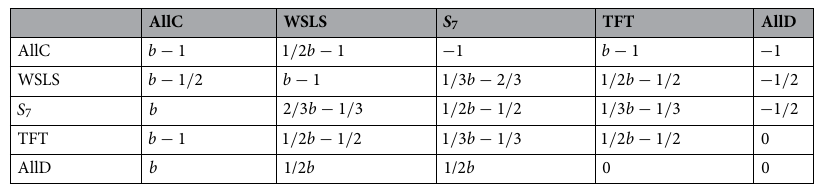
Table 2. Payoff matrix for the reduced strategy space, consisting of AllC, WSLS, S 7 , TFT, and AllD. The entry ( i , j ) is the payoff π ij that the (row) strategy i obtains against the (column) strategy j .